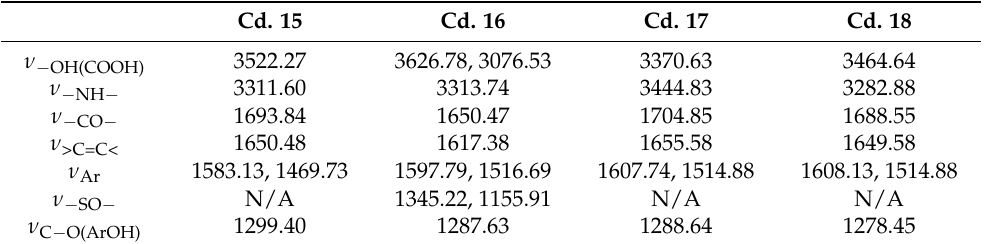
Table 6. The IR data of Cds. 15 – 18 (KBr pellets, ν max , cm − 1